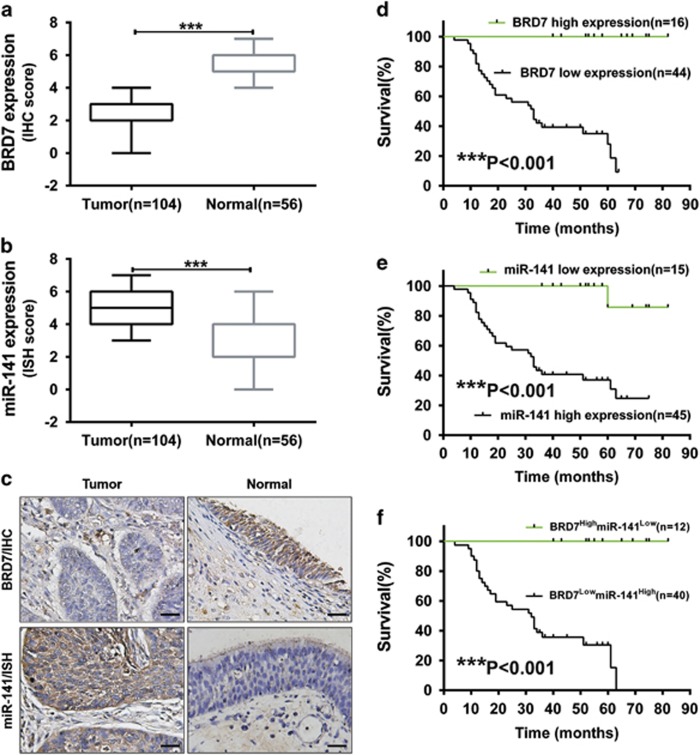
Increased expression of miR-141 was negatively correlated with BRD7 and patients' survival in human NPC. (a) BRD7 protein expression was analyzed by IHC (c, upper panel). (b) miR-141 expression was analyzed by ISH (c, lower panel). Box diagram of BRD7 and miR-141 expression in NPC (Tumor) (N=104) and non-cancerous nasopharyngeal control (Normal) (N=56) tissues, respectively. The whiskers represent the minimum and maximum values for each group. (c) Original magnification, × 200; the size bars represent 25 μm. (d–f) Kaplan–Meier analysis to plot the overall survival (OS) curve of 60 NPC patients by expression of BRD7 and miR-141. Clinicopathological characteristics and statistical significance were assessed using the log-rank test. Kaplan–Meier curves showed worse survival rates in NPC patients with low BRD7 protein expression and high miR-141 expression compared with the related controls, respectively. ***P<0.001